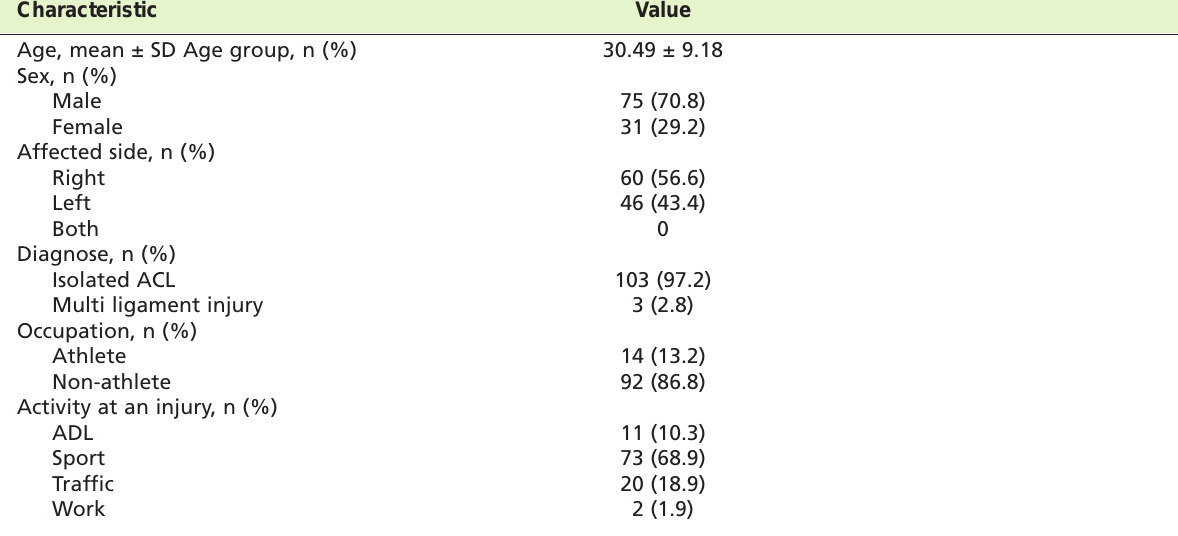
Demographic Patient Characteristics (n=106) Table II: